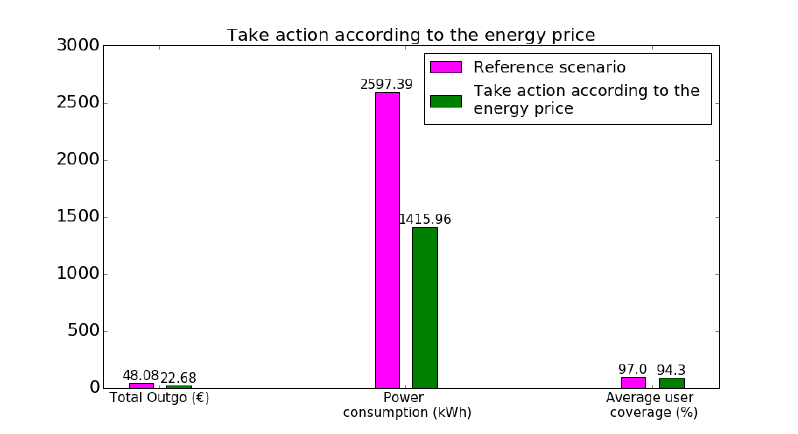
Figure 13. Take action according to the energy price: total outgo, power consumption and average user